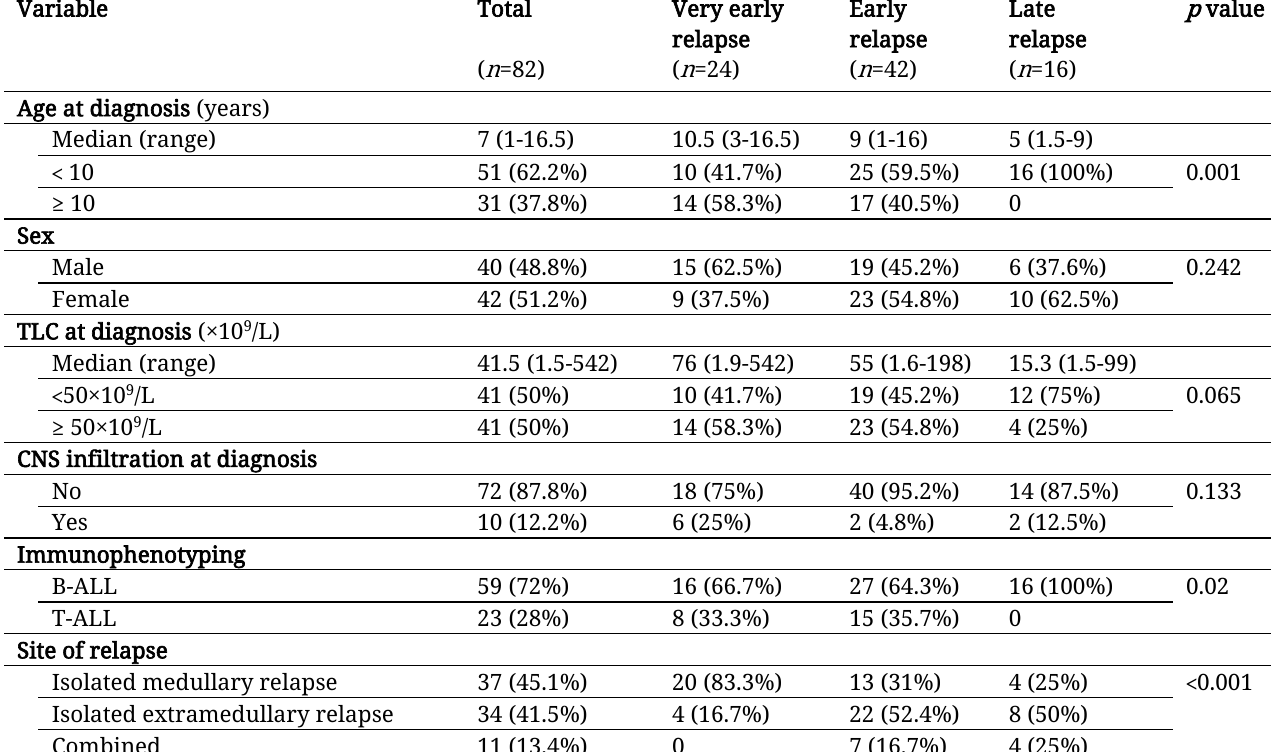
Table 1: Characteristics of 82 children with acute lymphoblastic leukemia in 1 st relapse